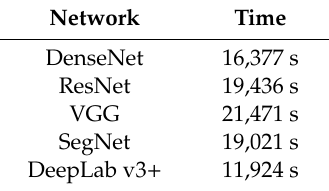
Figure 5. Training losses of the DenseNet, ResNet, VGG, SegNet and DeepLab v3+ models. One epoch represents 1000 iterations. Table 2. Training time of the DenseNet, ResNet, VGG, SegNet and DeepLab v3 + models.